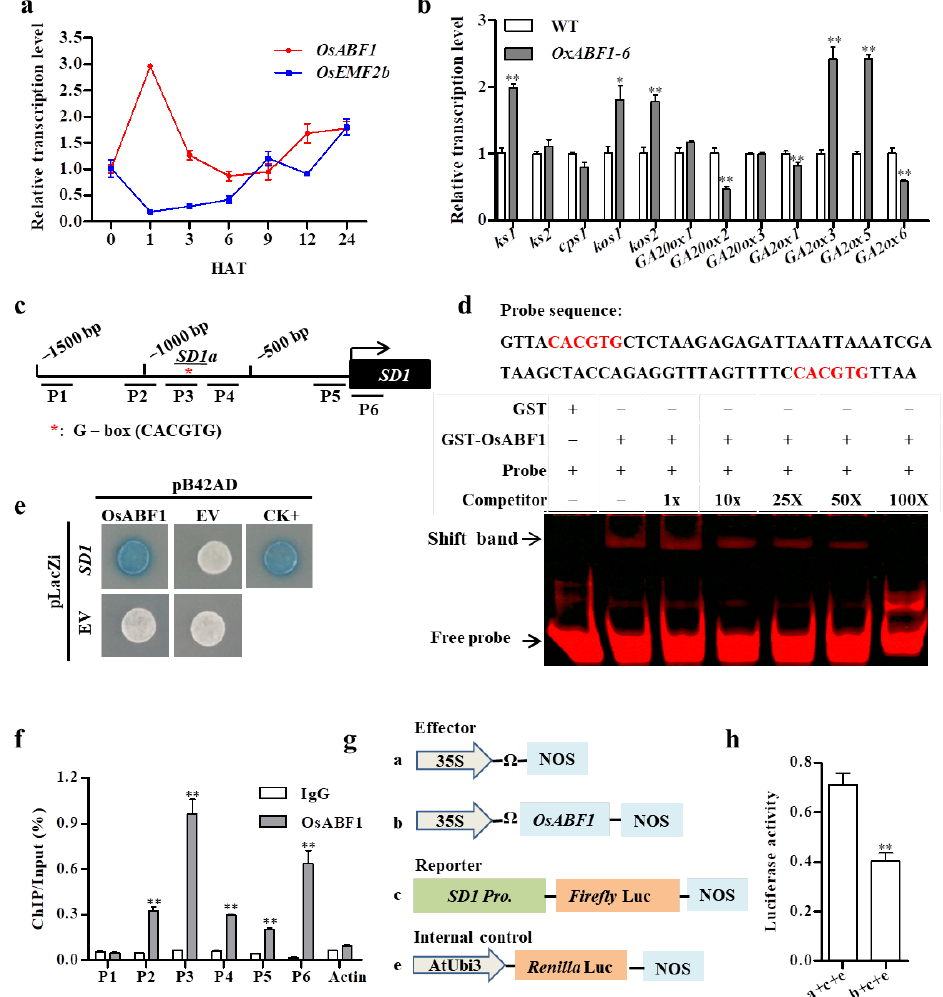
Figure 3. OsABF1 directly bound to the SD1 promoter and repressed its transcription. ( a ) Time-course expression level of OsABF1 in 15-day-old seedlings upon 100 µ M exogenous GA 3 treatment. HAT: hours after GA treatment. ( b ) The expression levels of GA-related genes in WT and OxABF1-6 leaves at tillering stage. ( c ) Schematic presentation of the SD1 promoter regions (1500bp upstream of the SD1 transcription start site). Bar 1 to 6 indicate the regions checked by ChIP-qPCR. The red asterisk ( SD1a ) represents the position of the G-box motif. ( d ) EMSA assay showed OsABF1 directly binds to the promoter of SD1 . The 1 × , 10 × , 25 × , 50 × , and 100 × fold excess non-labeled probes were used for competition. The red letter represented G-box. ( e ) Yeast one-hybrid assay showed that OsABF1 could bind to the SD1 promoter (1500 bps upstream of the SD1 transcription start site); UDT1-pB42AD and RMS2-pLacZi were used as CK + . ( f ) ChIP-qPCR analysis of the OsABF1 enrichment on SD1 promoter in OxABF1-6 . ( g , h ) Luciferase (LUC) transient transcriptional activity assay in rice protoplast. Error bars represent means ± SD ( n = 3). * p < 0.05, ** p < 0.01 by Student’s t -test analysis .